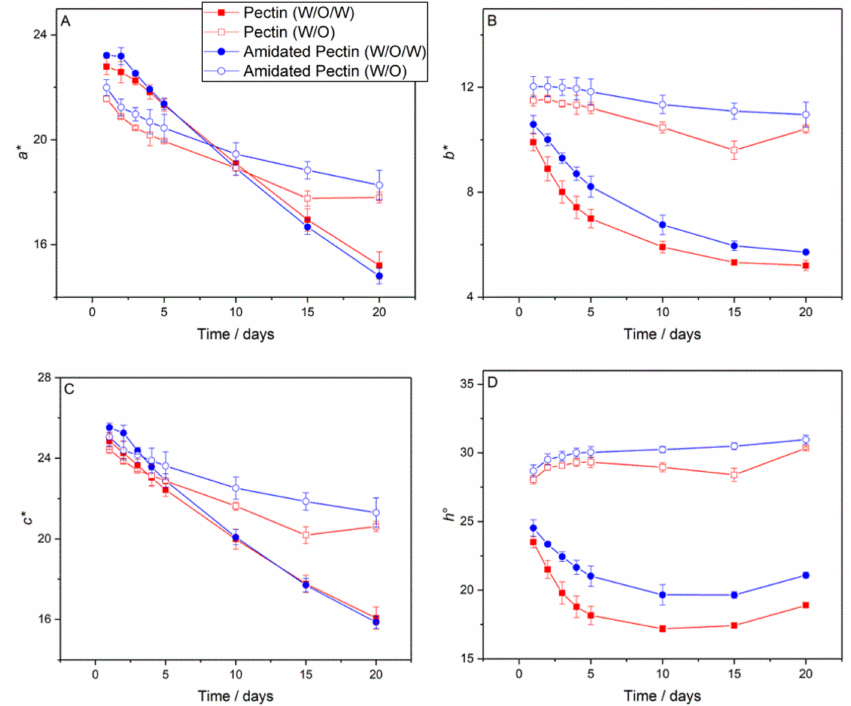
Figure 8. The effect of pectin chemistry on ( A ) a* ; ( B ) b* ; ( C ) c* ; and ( D ) h ◦ . Samples containing unmodified pectin are shown as squares (red), samples containing amidated pectin are shown as circles (blue), W 1 /O/W 2 emulsions are represented with by closed symbols, and W 1 /O emulsions by open